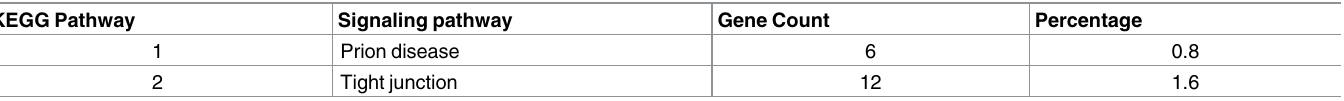
Table 5. Signaling pathways that were unique to day 14 (Hyperoxaluria) only when compared with day 28. KEGG